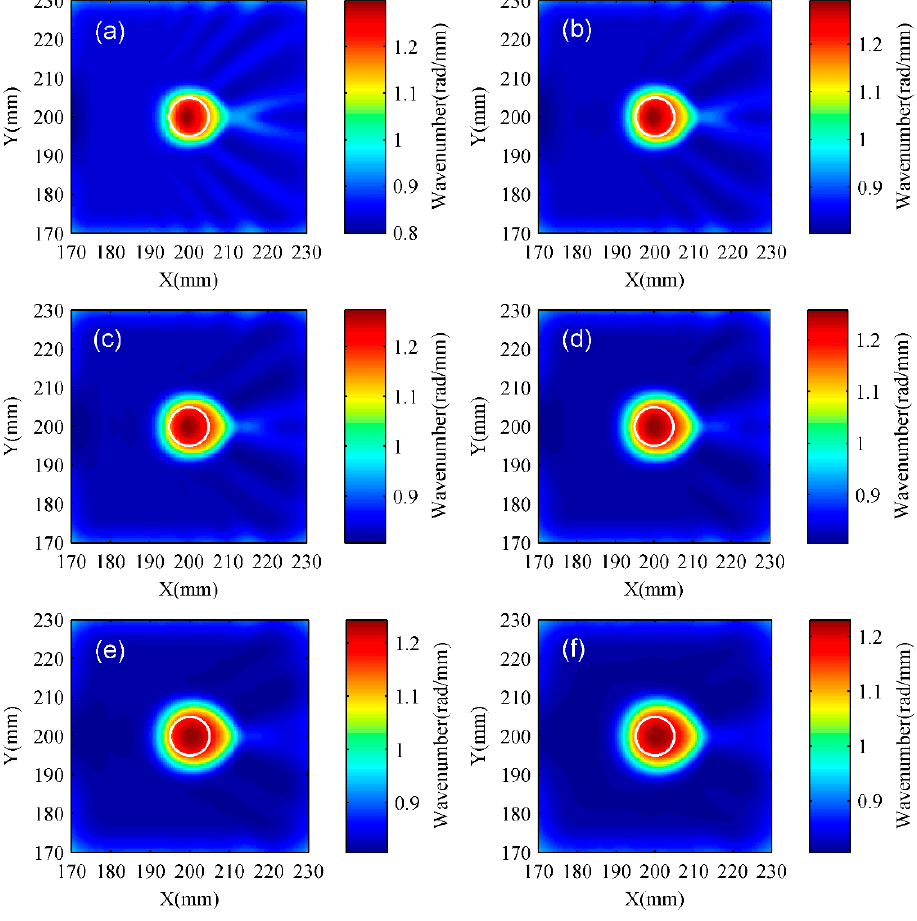
Figure 9. The test results obtained under various window radii. ( a ) 8 mm; ( b ) 9 mm; ( c ) 10 mm; (d) 11 mm; ( e ) 12 mm; ( f ) 13 mm. The white circle represents the actual location of the damage. The central frequency of the excitation signal is 200 kHz.